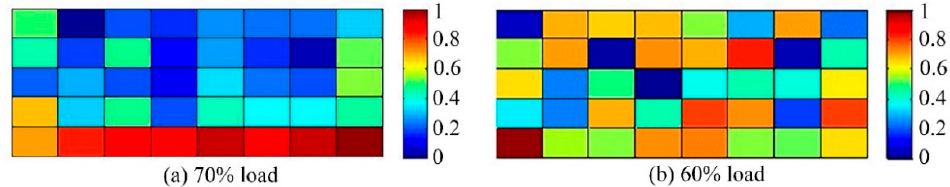
Figure 25. Contours of probability distribution of the unexpired load.